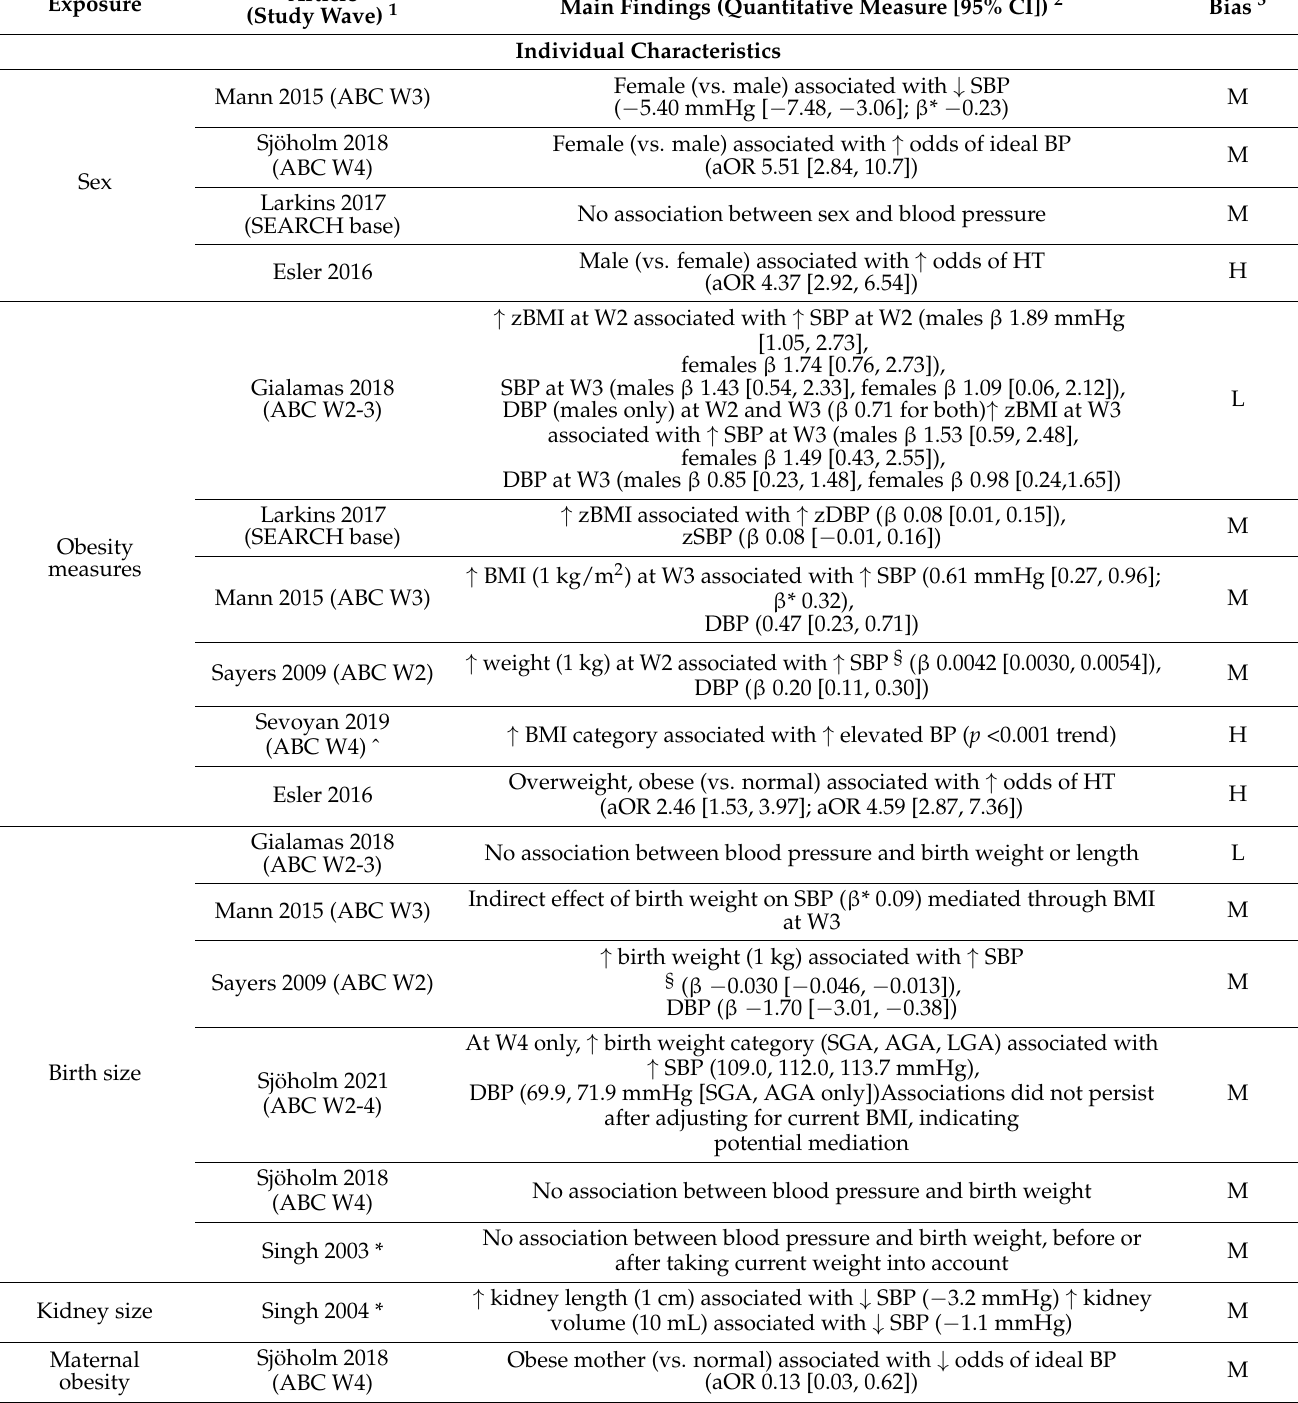
Table 5. Quantitative associations with blood pressure outcomes, arranged by exposure type and listed in order of lowest to highest risk of